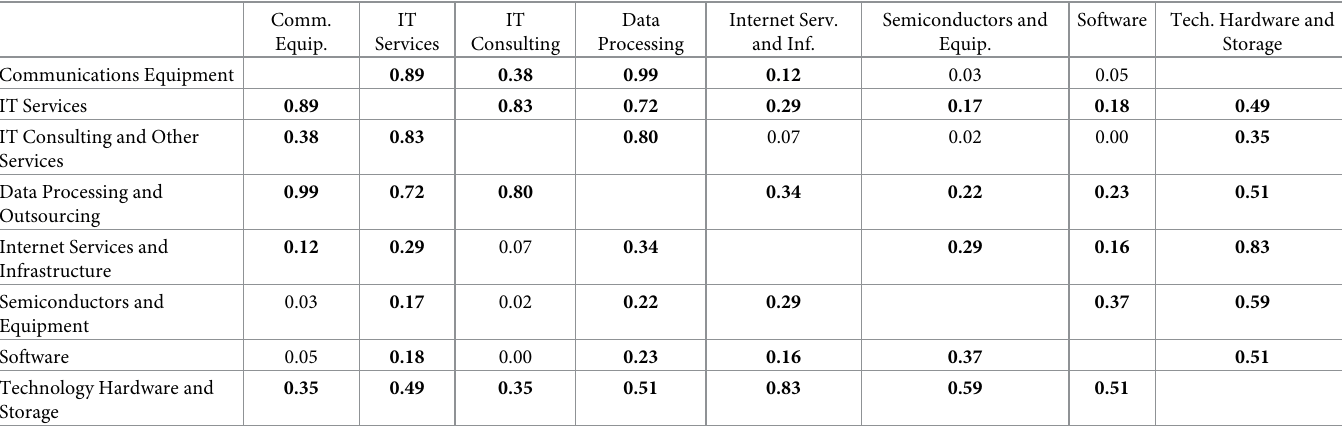
Table 12. Information technology industry.